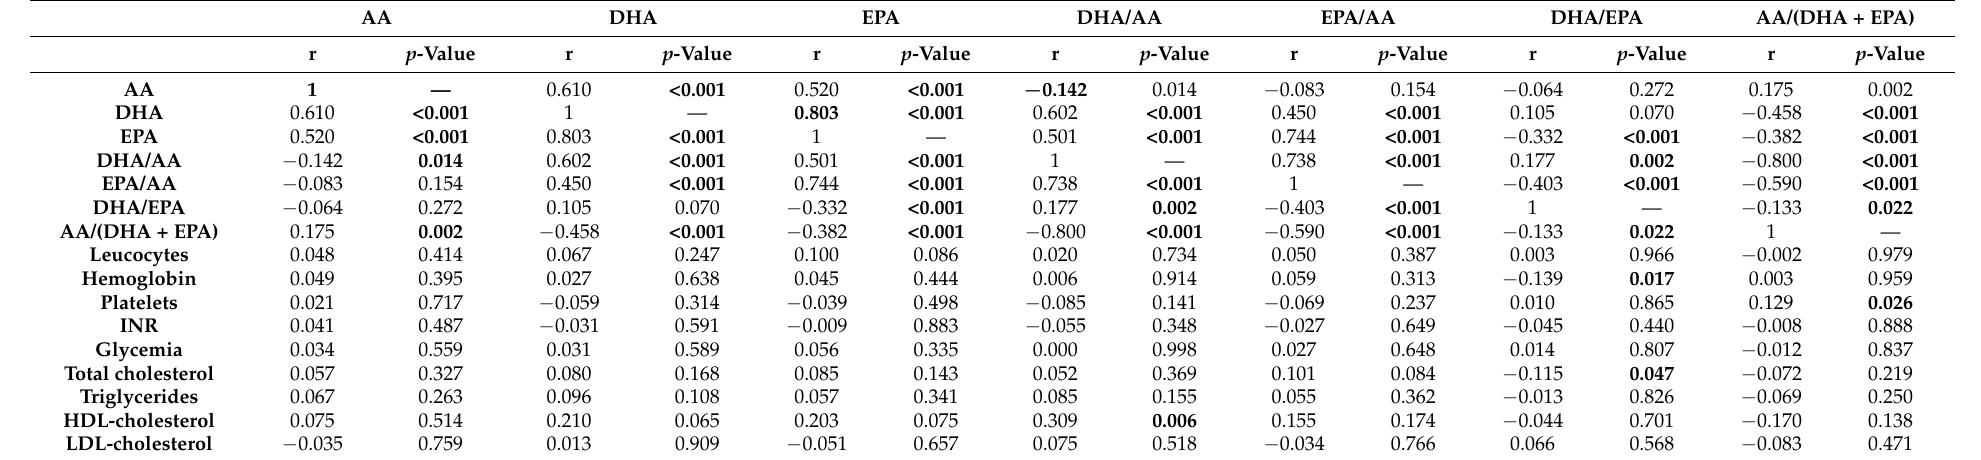
Table 9. Pearson correlations between fatty acids and all paraclinical parameters.